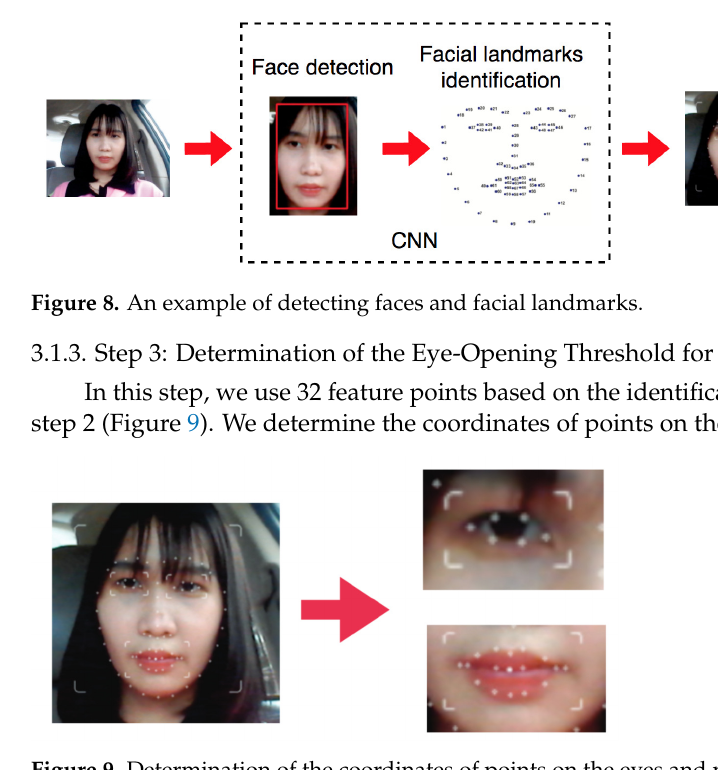
Figure 9. Determination of the coordinates of points on the eyes and